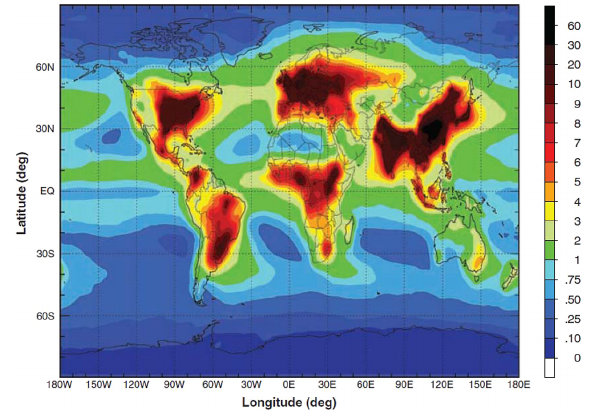
Figure 5. Nitrogen accumulation rates in terrestrial ecosystems un- derlain by N-bearing vs. non N-bearing lithologies. The dashed line is the cutoff for rates of N accumulation that exceed estimates of table for metadata and N-lithology determination (modified reanal- ysis of Binkley et al., 2000, and Johnson and Turner, 2014).